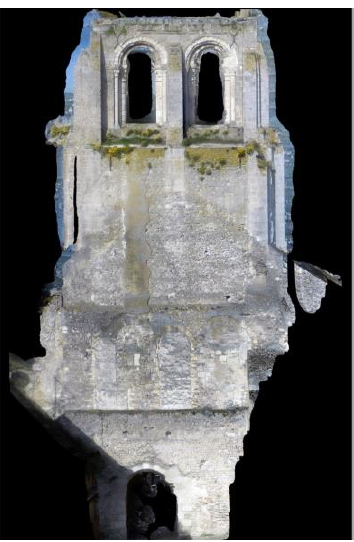
Figure 7. Orthoimage of the north wall of the Du Puy chapel